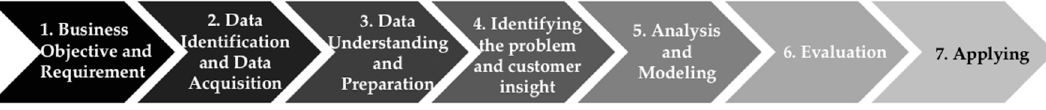
Figure 3. Process for adapt big-data analytics for service innovation. Source: Compiled by authors according to a semi-structured interview.